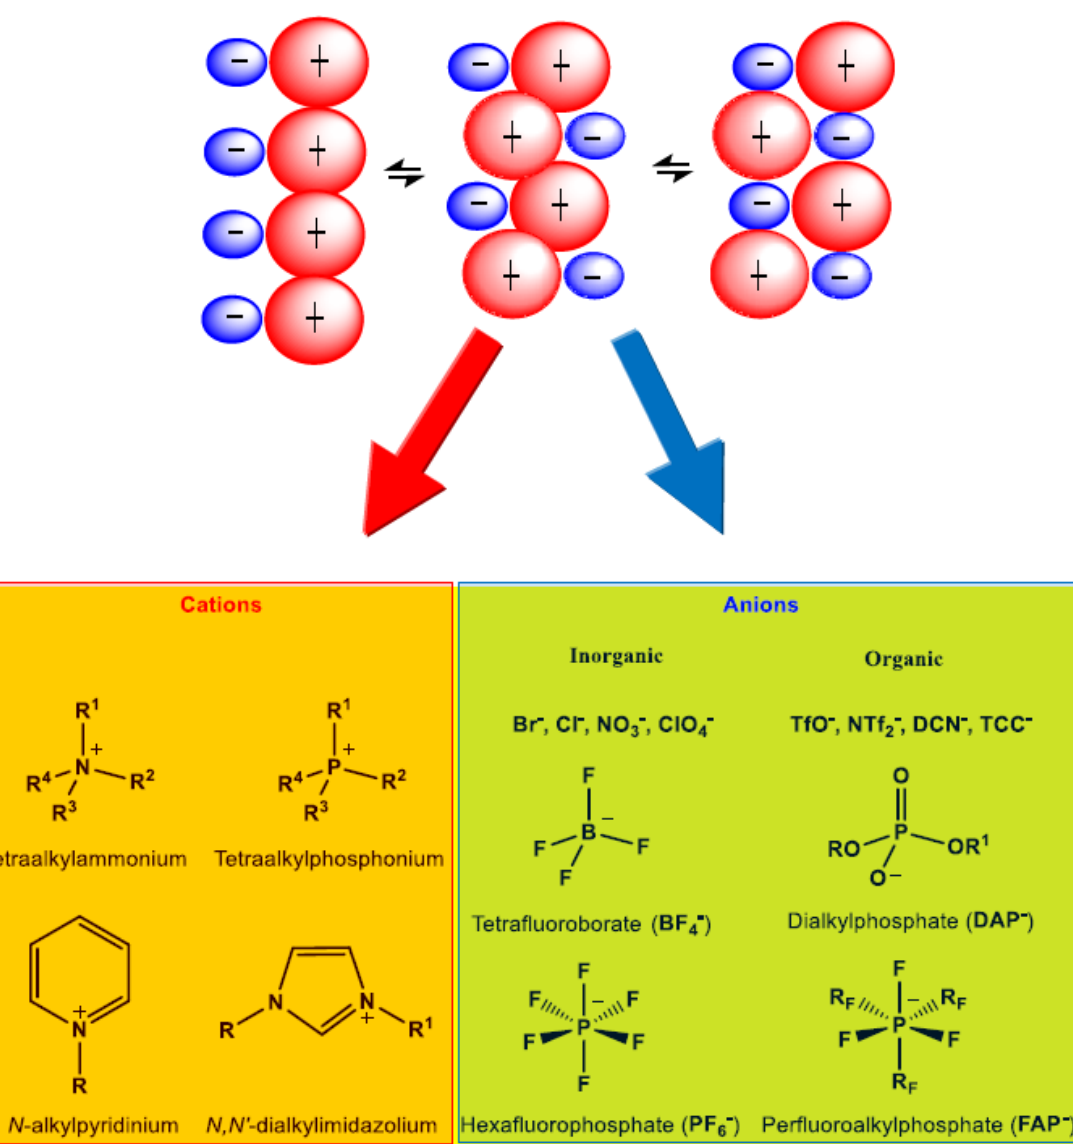
Figure 1. Common cations and anions of ILs.